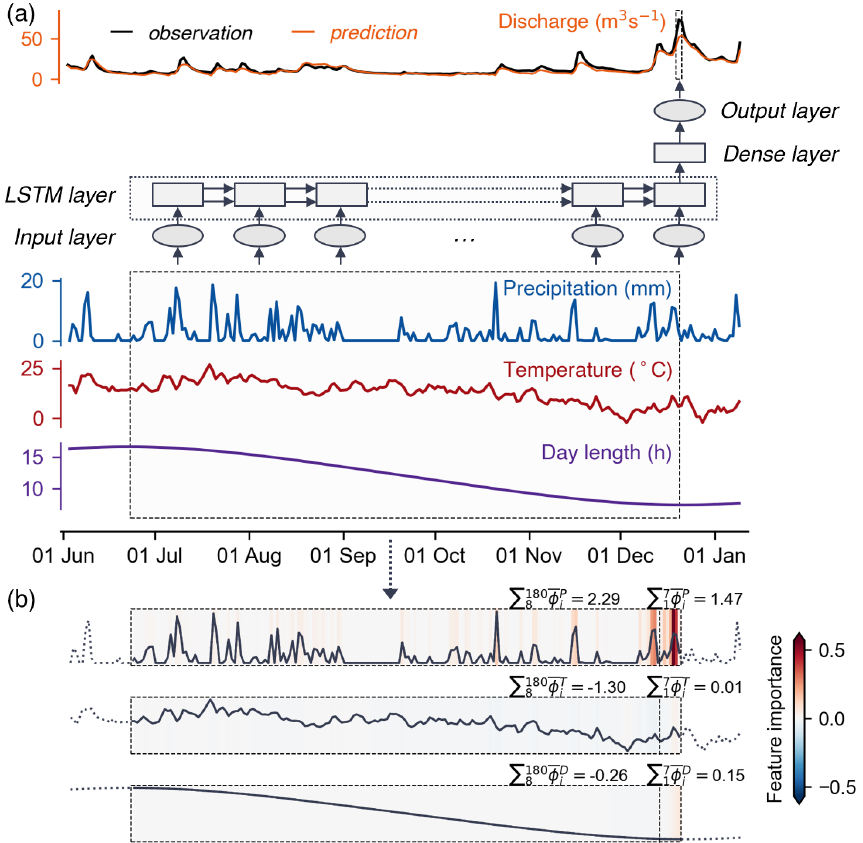
Figure 2. The workflow of using explainable ML methods for attributing flood peaks (annual maxima of river discharge) to their drivers. (a) Diagrammatic representation of the used LSTM models. The window in the time series of discharge highlights the target output (which is a point), and the window in the inputs indicates the input features used to predict the illustrated peak discharge sample. (b) The feature importance of the inputs for predicting the peak discharge shown in (a) , which was obtained by using the ML interpretation technique (namely integrated gradient). The vertical dashed lines in the windows separate the feature importance into a recent 7d period and an earlier period to calculate the aggregated feature contributions (see main